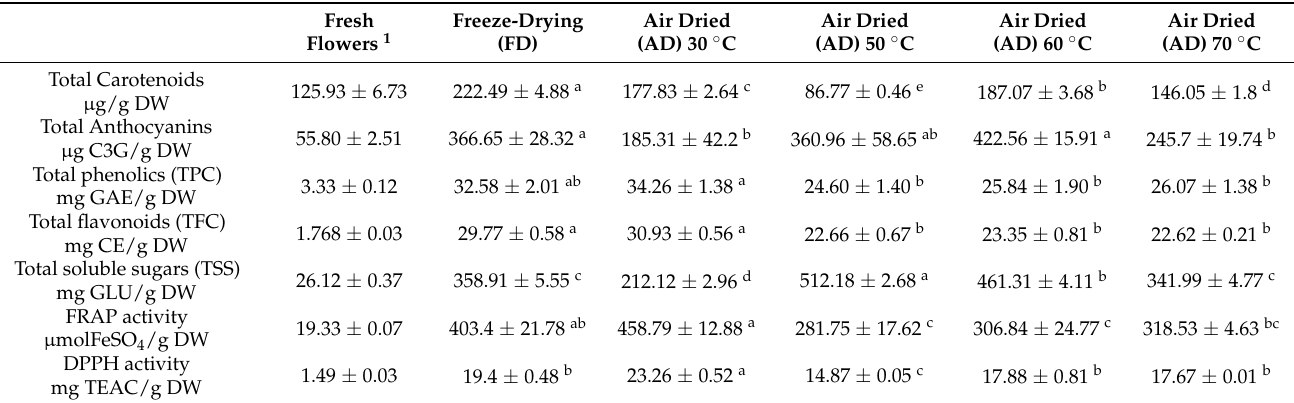
Table 1. Determination of metabolites in A. aurantiaca flowers subjected to different treatments. Data are presented as means ± standard error (SE, n = 3). Abbreviations: FW = fresh weight; DW = dry weight; GAE—gallic acid equivalents; CE—